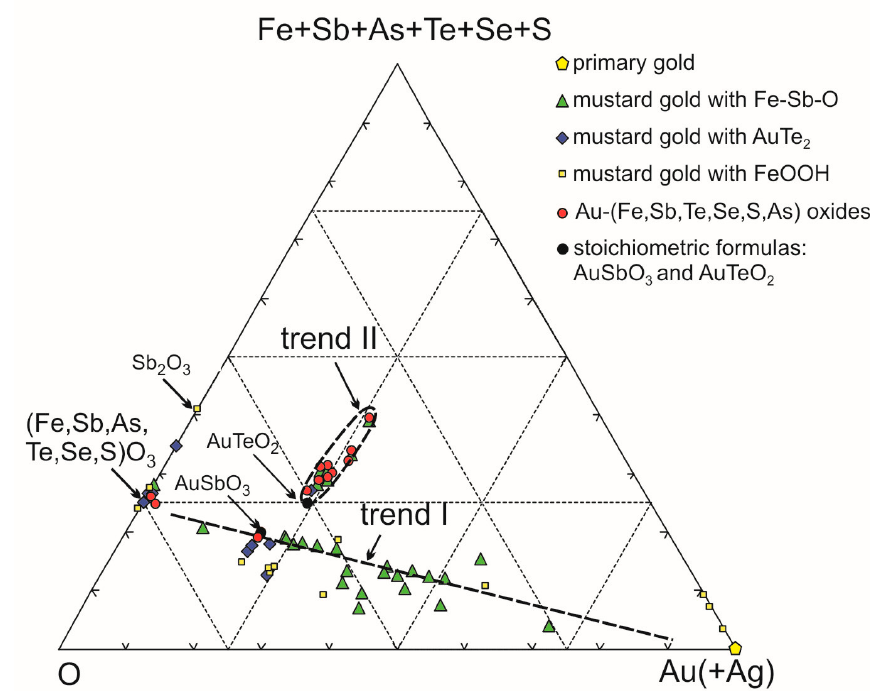
Figure 9. The composition of mustard gold mixed with Fe–Sb–Te–As–Se–S-oxide matrix (trend I) and Au-complex oxides (trend II) in O–Fe + Sb + As + Te + Se + S–Au (+Ag) diagram from the various associations shown in the Figures 2, 4, and 6–8.